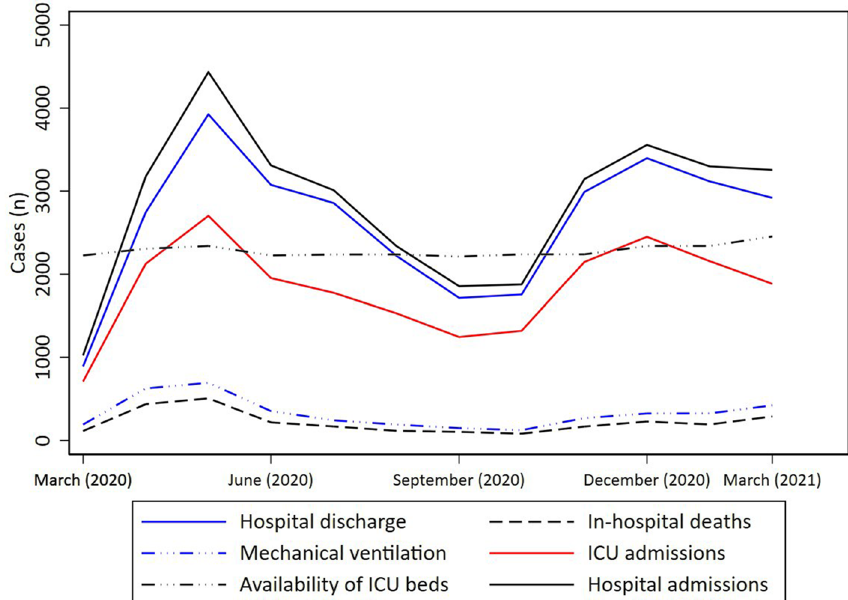
Figure 1. Patient distribution according to number of hospital admissions, hospital discharges, in-hospital deaths, patients on mechanical ventilation, intensive care unit (ICU) admissions, and the variation on ICU-bed availability from March 1st, 2020 to March 31st,